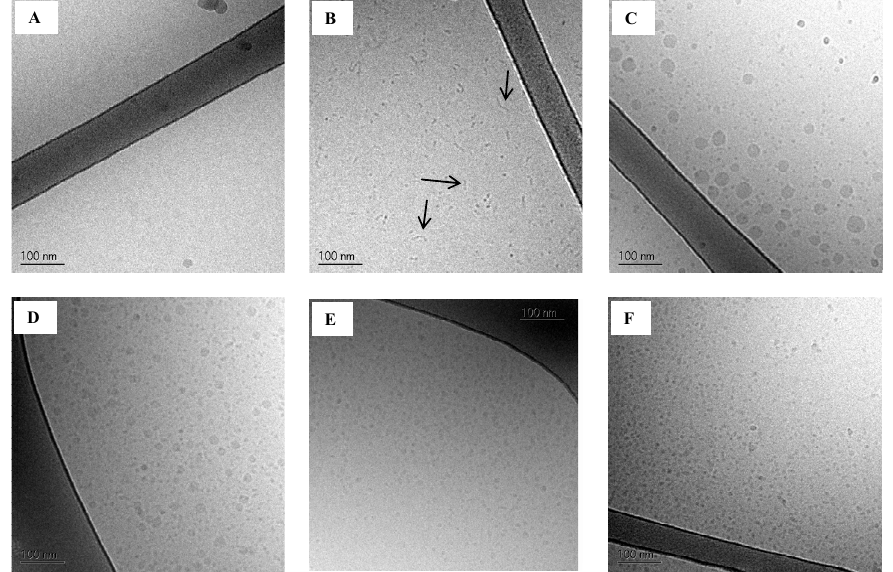
Figure 6. Cryo-TEM images of background ( A : trizma maleate buffer pH 6.5 and B : SIM pH 6.5, arrows are pointing at the rod like structures) and SNEDDSs dispersed low pH 6.5; C : SNEDDS I; D : SNEDDS II; E : SNEDDS III and F : SNEDDS (1% w / w ) in SIM low